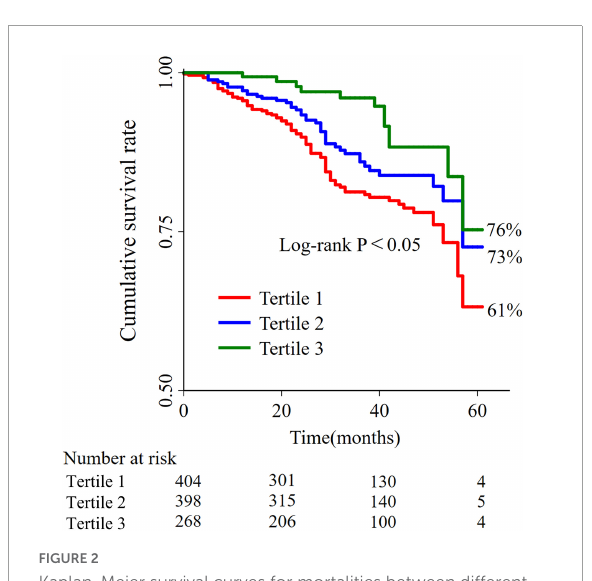
FIGURE2 Kaplan-Meier survival curves for mortalities between different albumin